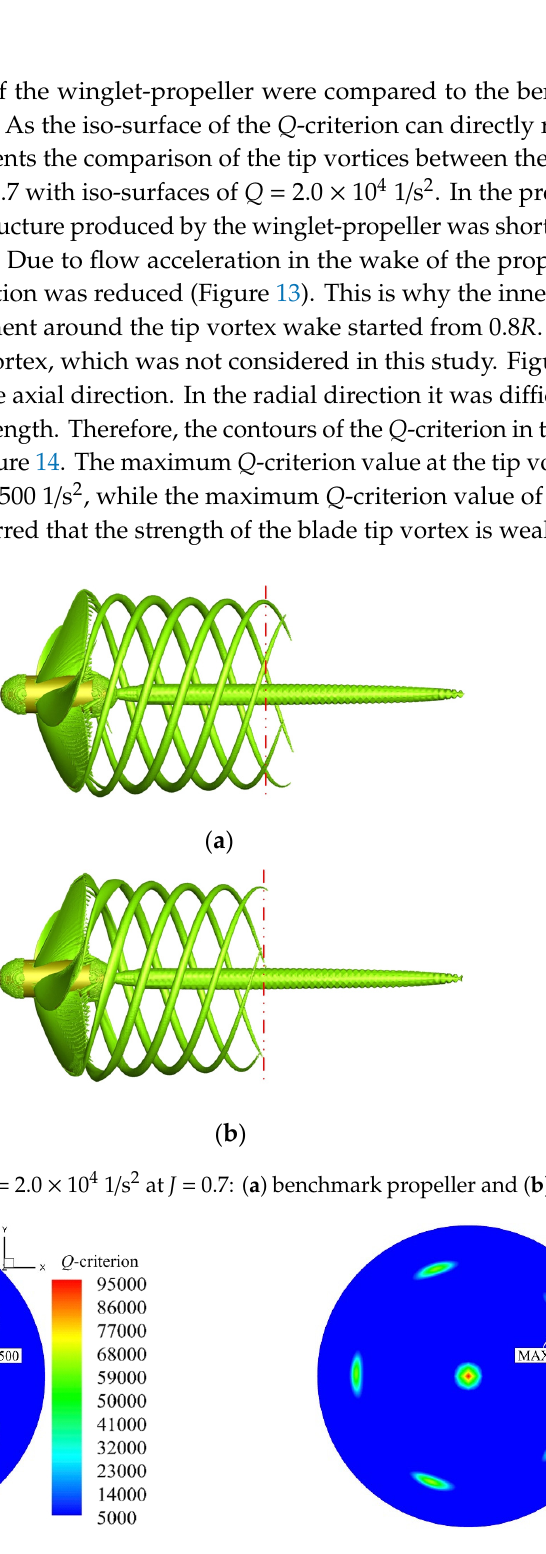
Figure 12. Power spectral density (PSD) of axial velocity at different locations.